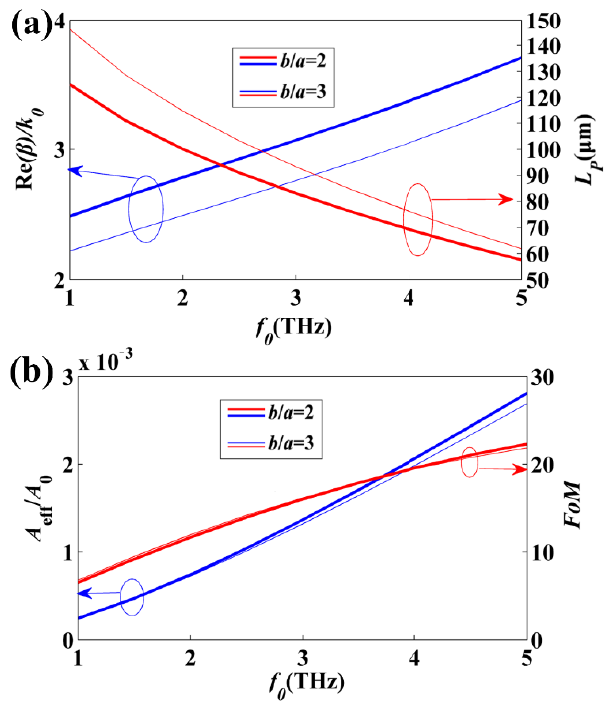
Figure 3. ( a ) Real part of n eff and L P , and ( b ) A eff / A 0 , and figure of merit ( FoM) of the GP mode as a function of frequency. Here u c = 0.5 eV, and a = 0.5 μm . The thick and thin lines stand for b/a = 2 and b/a = 3, respectively.